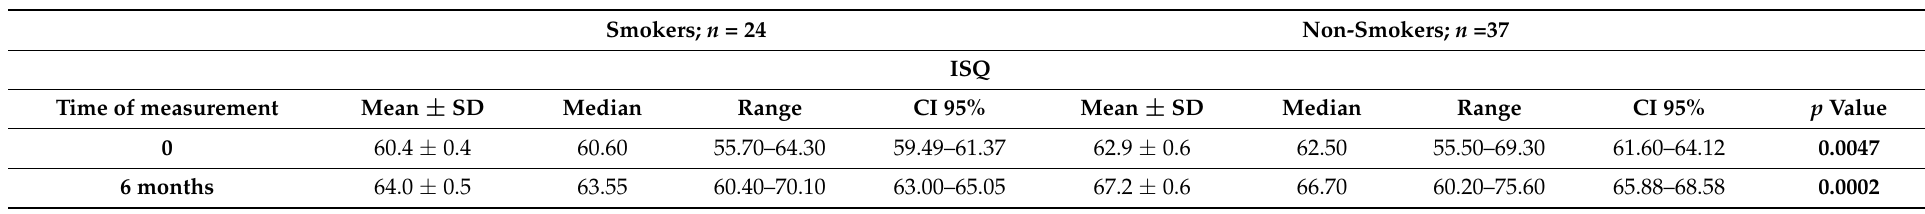
Table 4. Implant stability and bone atrophy in the posterior area of smokers and non-smokers, following immediate implantations in maxilla (ISQ—mean Implant Stability Quotient; PT— periotest